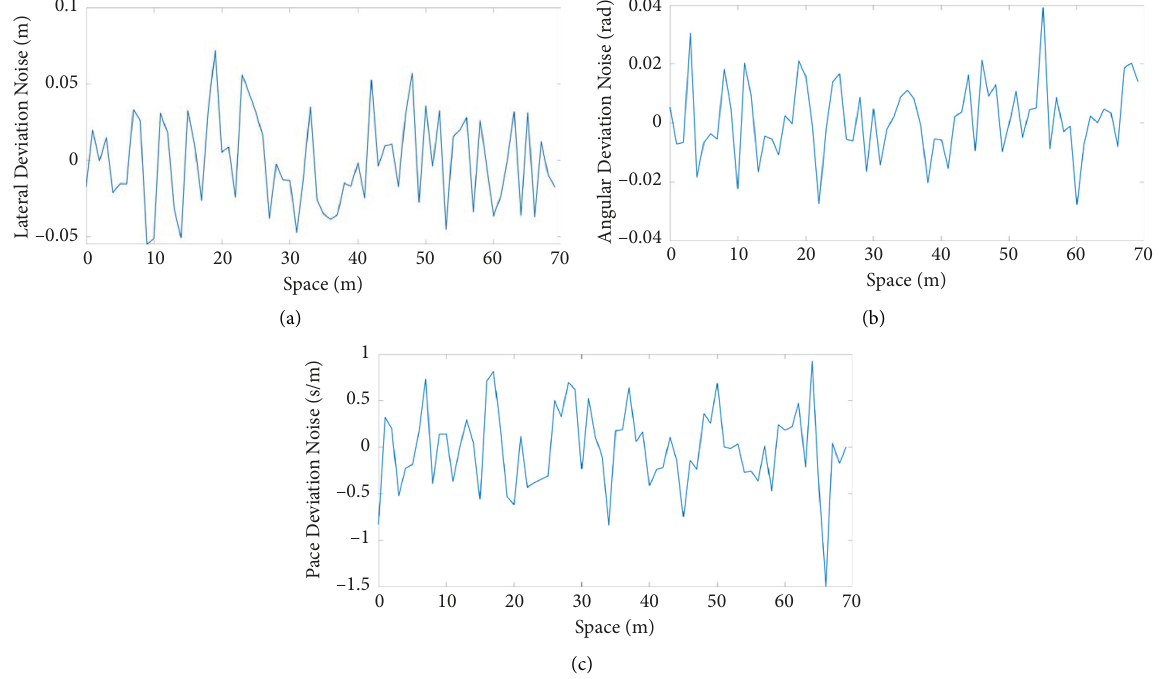
Figure 12: System disturbance: (a) lateral deviation noise; (b) angular deviation noise; (c) pace deviation noise.